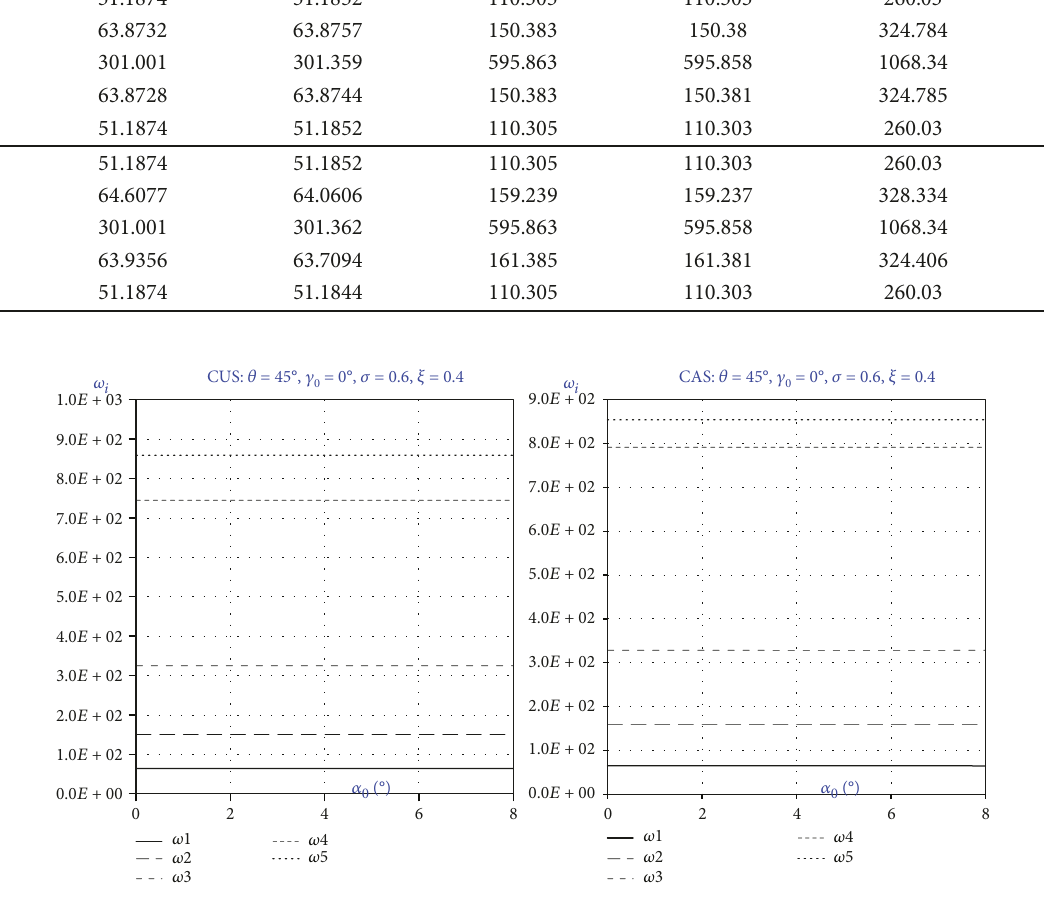
Figure 12: Eigenfrequencies vs. ply angle of Model A via α